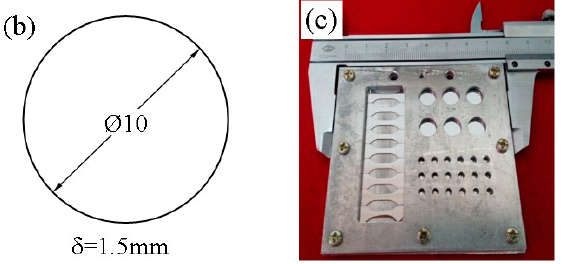
Figure 1. Dimensions of irradiated specimens of tempered 5140 alloy steel. ( a ) Micro tensile specimen. ( b ) Nanoindentation specimen. ( c ) Clamping die of proton irradiated sample.